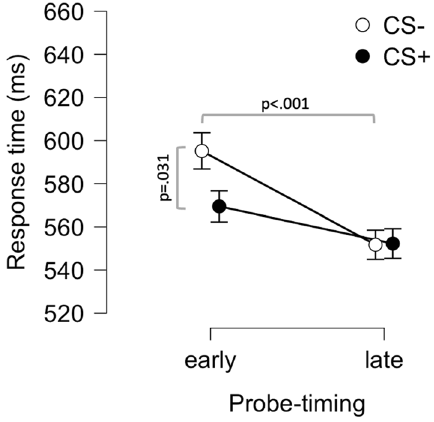
Figure 3. Response times to early and late auditory probes during presentation of conditioned stimuli (CS) in the acquisition phase. Response time to the neutral stimulus paired with an aversive outcome (CS +) was faster than to the stimulus never paired with an aversive outcome (CS−) during early (500 ms after onset of CS) but not late (2500 ms) probes. Points and error-bars indicate means and